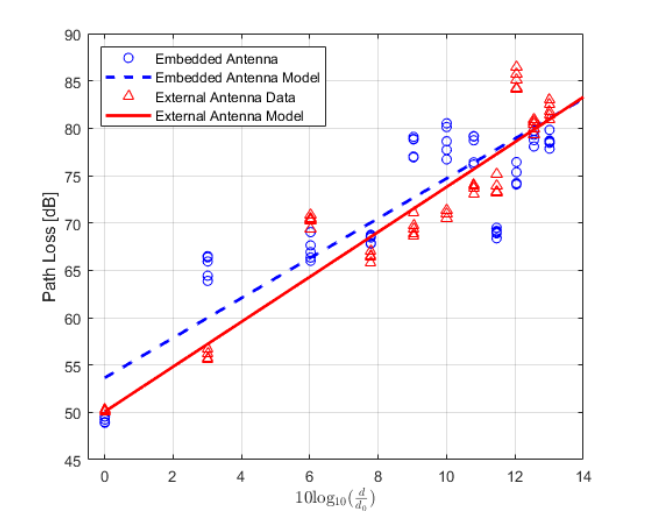
Figure 8. IQRF path loss model for Line-of-Sight scenario.